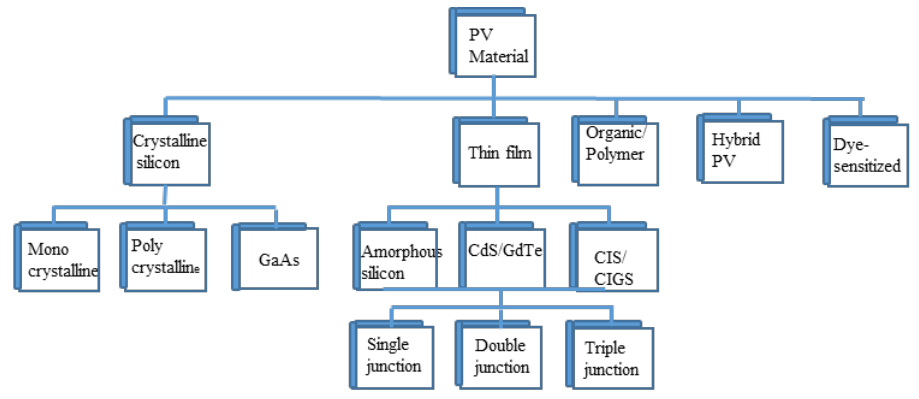
Figure 10. A PV material chart. Adapted from [18].